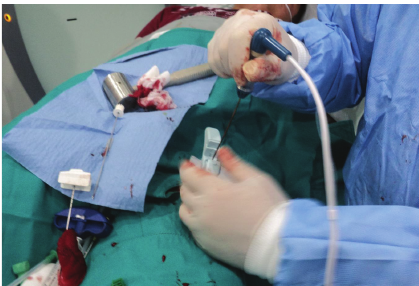
Figure 4: The trochar removed and electrode was placed through cannula.